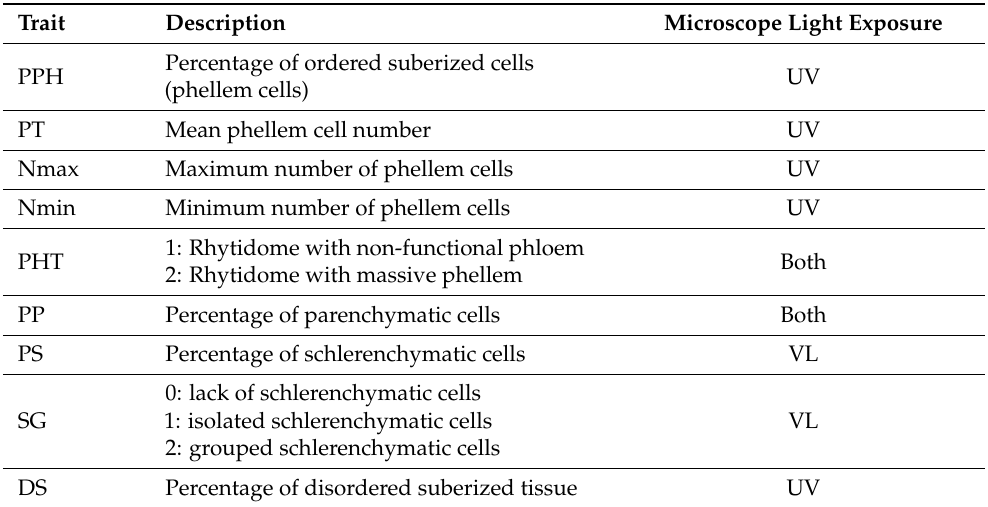
Table 2. Description of the measured traits for outer bark anatomical characterization. VL: visible light; UV: Ultra-violet